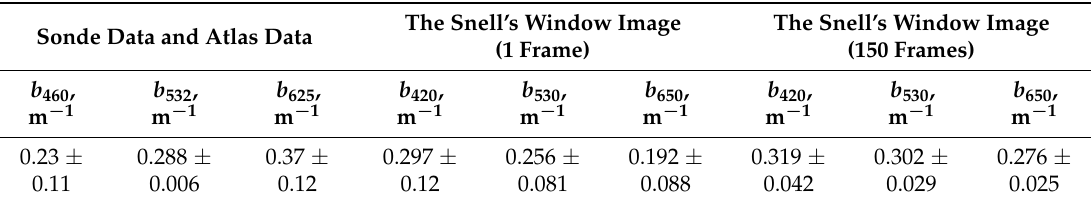
Table 6. The recovery results of the scattering coefficient of the Black Sea from the Snell’s window images in comparison with related